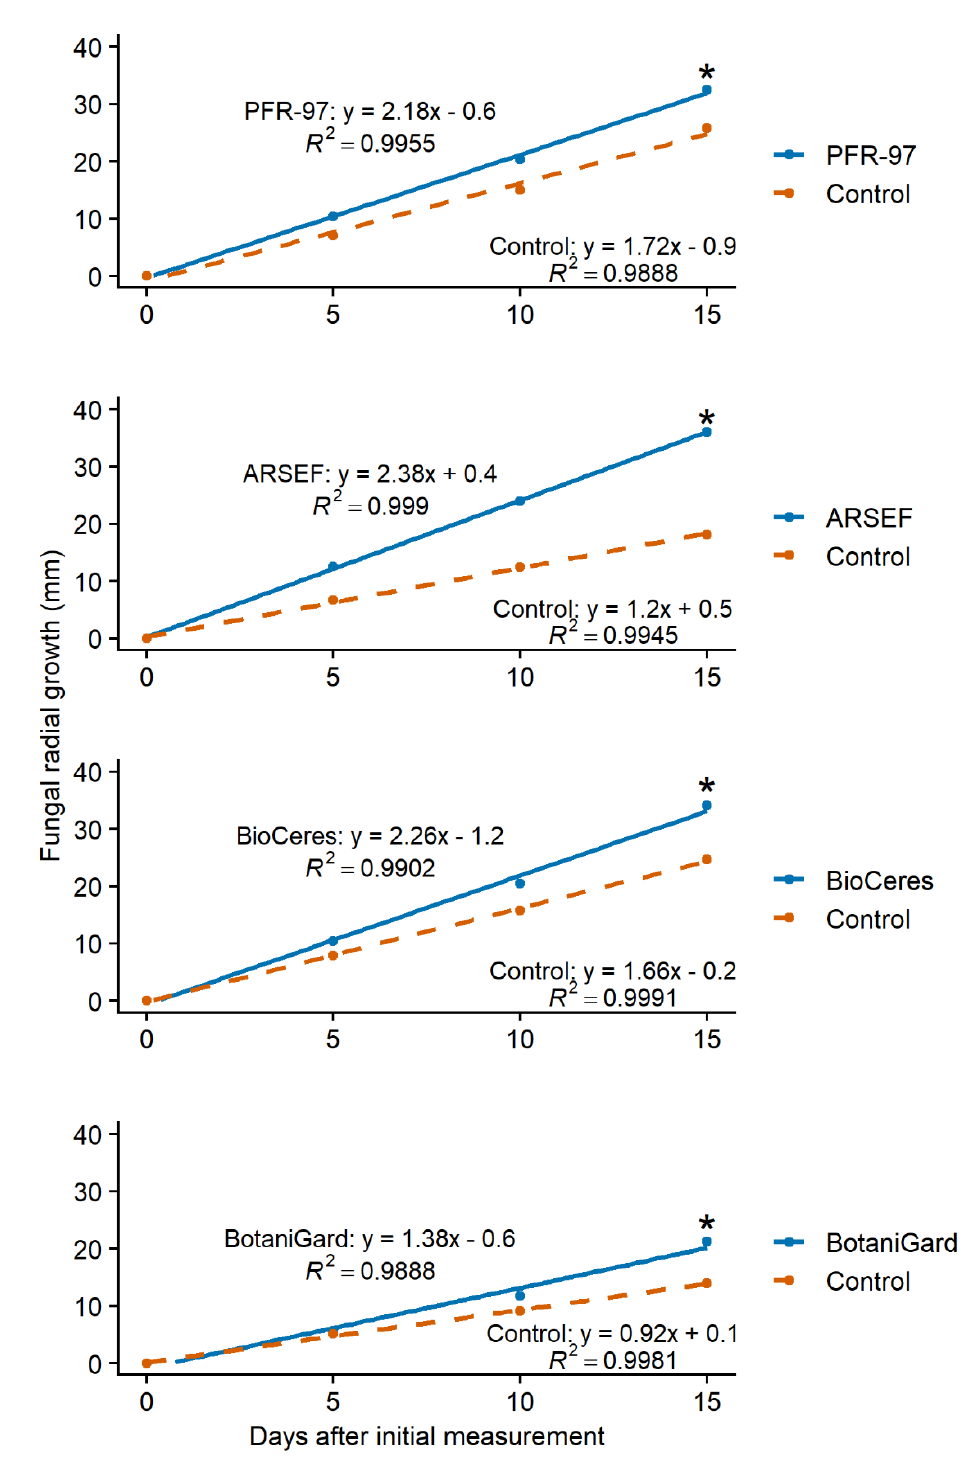
Figure 3. Linear models of fungal radial growth for four entomopathogenic fungal products grown on PDA with 50% concentration of bok choy leaf extract compared to its control treatment model over a 15-day observation period. Asterisk (*) above a line endpoint represents significance between treatment and control linear models (Student’s t -test, p < 0.05).